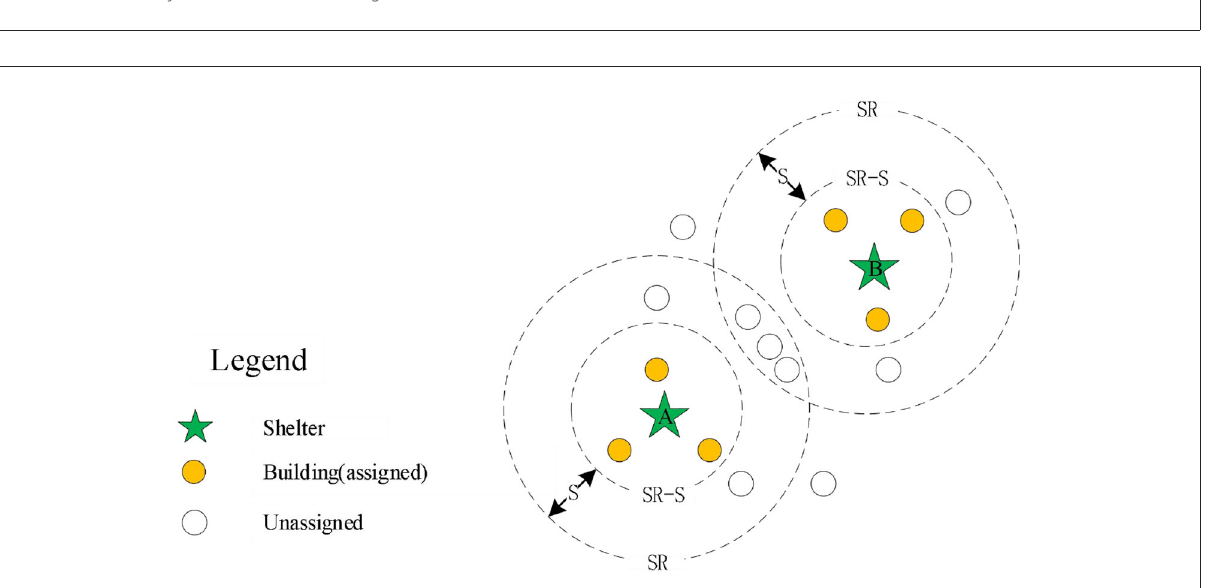
FIGURE4 The scenario analysis of with intersecting